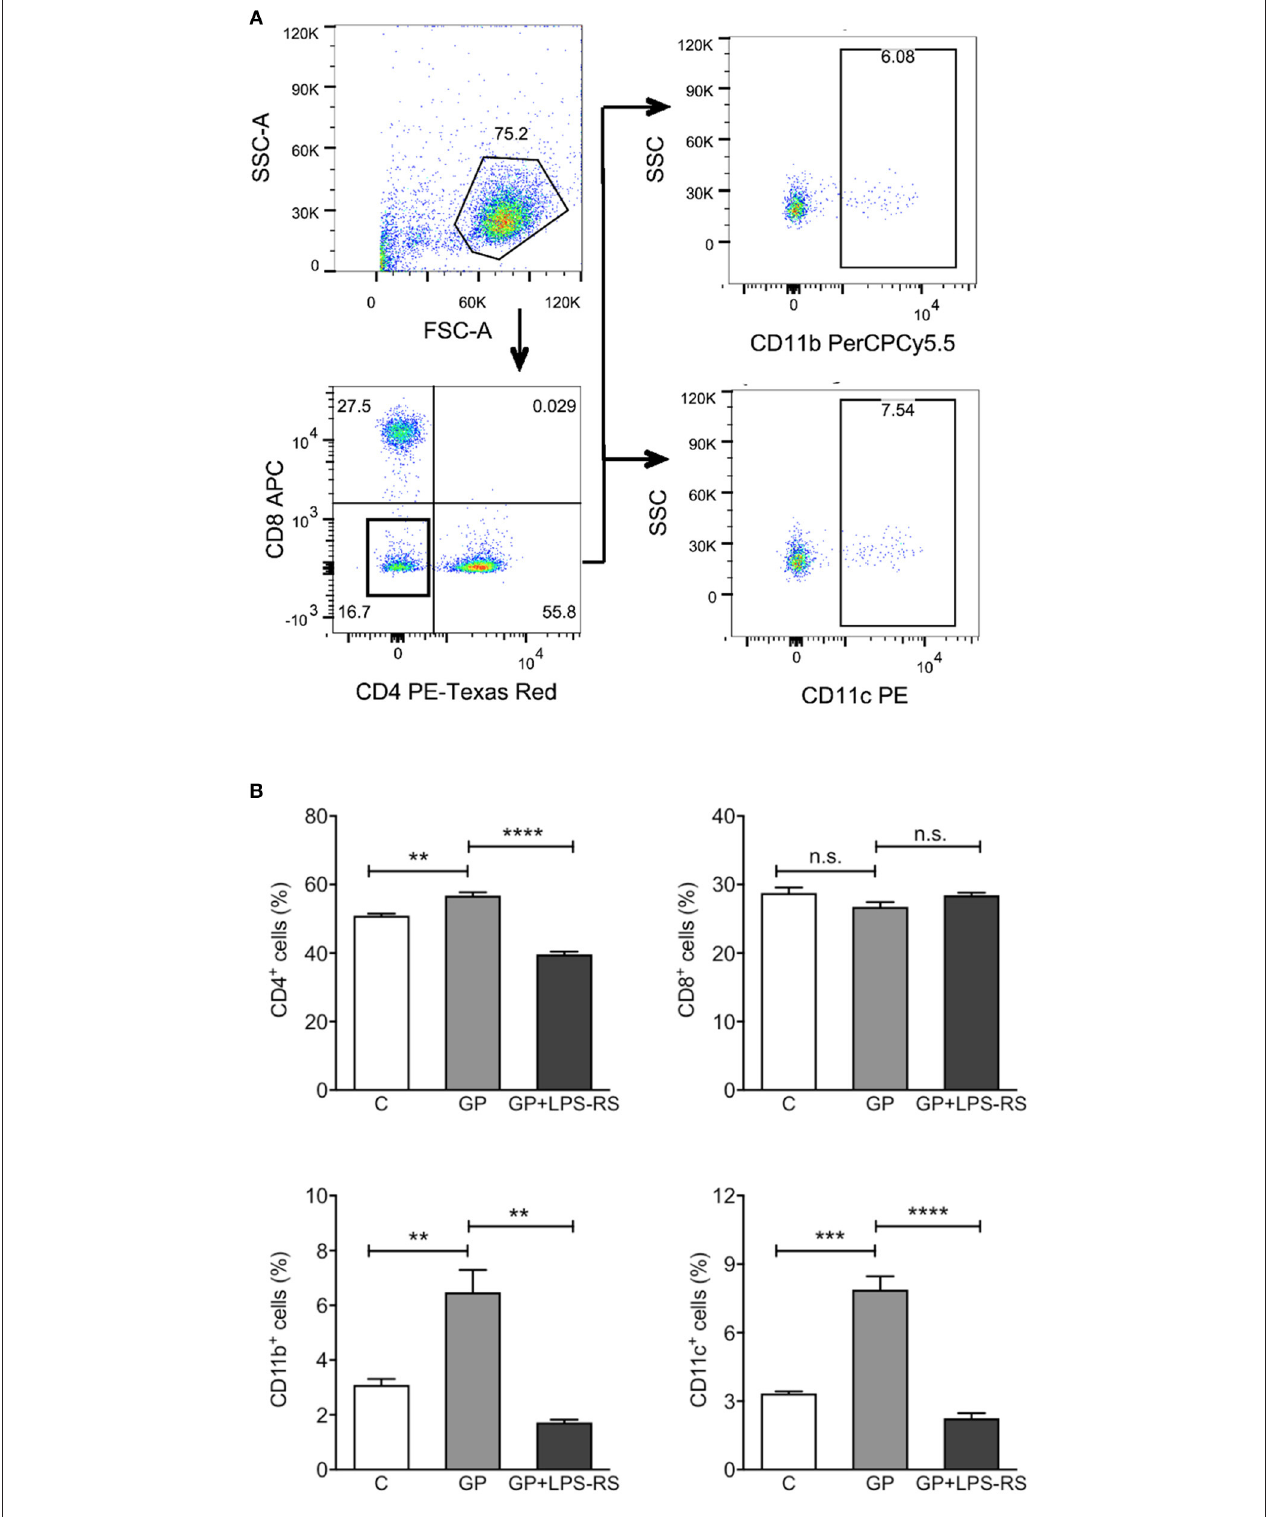
FIGURE 6 | GP-associated innate immune response affects homing of immune cells into the draining lymph nodes. C57BL/6 mice were administered intraperitoneally with PBS (C), GP alone (100 µ g per mouse), or GP + LPS-RS as described previously. Inguinal lymph nodes (LNs) were harvested at 24 h after treatment,